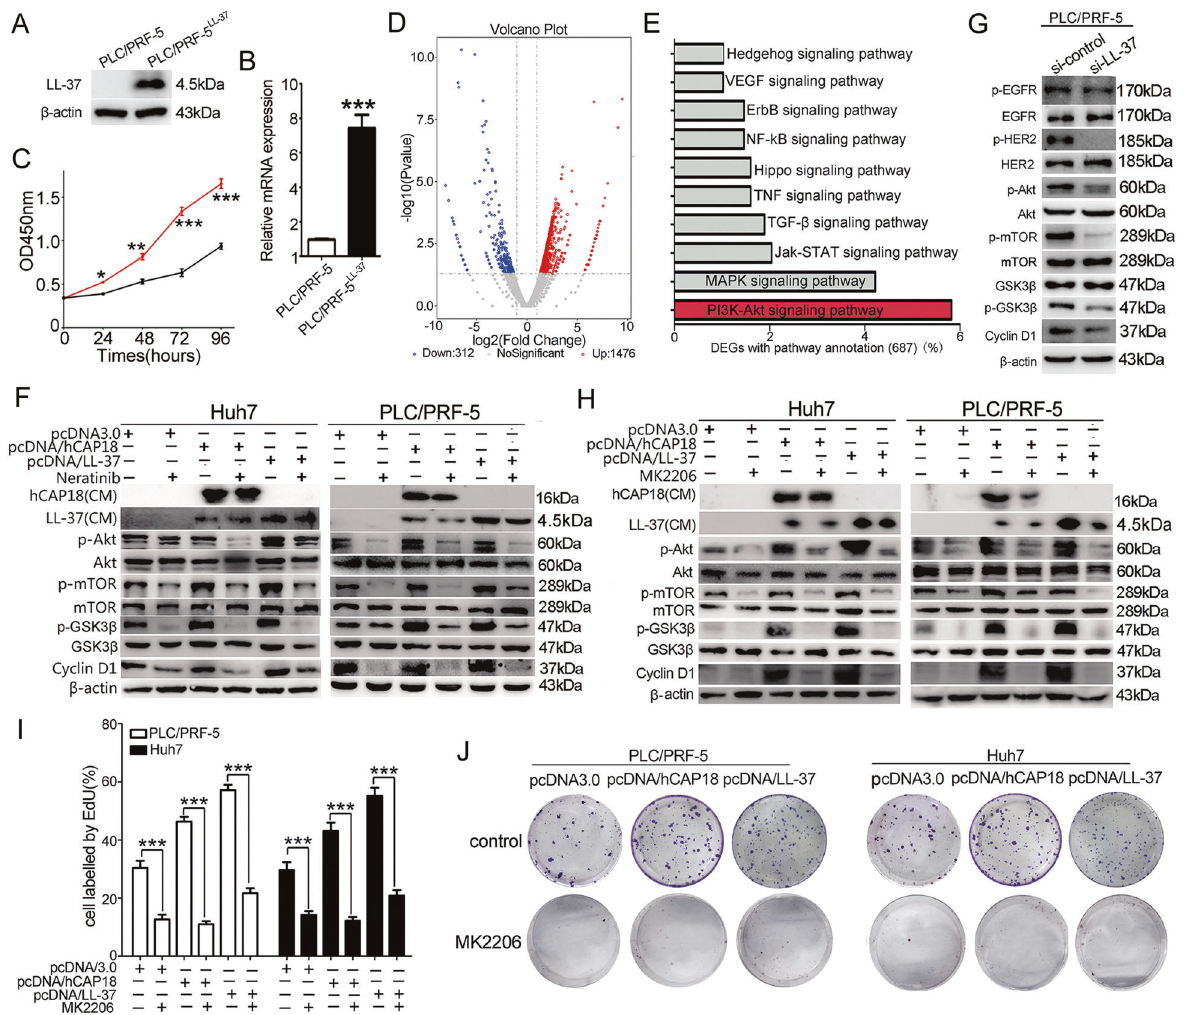
Fig. 5 hCAP18/LL-37 regulates PI3K/Akt signaling pathway in HCC cells. Stable LL-37-overexpressing cell line PLC/PRF-5 LL-37 was veri fi ed by western blotting ( A ), qRT-PCR ( B ), and cell growth curve analysis by CCK-8 assay ( C ). D Transcriptome sequencing identi fi ed genes involved in PLC/PRF-5 LL-37 . Volcano plot shows differential gene expression (red: upregulated; blue: downregulated) in PLC/PRF-5 LL-37 cells compared to PLC/PRF-5 cells. Log2 fold change is represented on x -axis, while y -axis represents – log10 p -value. E Top ten KEGG pathways enriched in genes differentially expressed in PLC/PRF-5 LL-37 cell. F PI3K/Akt pathway was measured in PLC/PRF-5 and Huh7 cells using western blotting. After transfection with pcDNA/hCAP18 or pcDNA/LL-37 for 24 h, 3 μ M neratinib was added. Protein levels were detected another 24 h. G After transfection with si-LL-37 for 48 h, protein levels were measured in PLC/PRF-5 cells. H After pcDNA/hCAP18 or pcDNA/LL-37 transfection for 24 h, AKT inhibitor (MK2206, 5 μ M) was added for another 24 h incubation and then protein levels were measured in PLC/PRF-5 and Huh7 cells. EdU proliferation assays ( I ) and colony formation assays ( J ) were conducted in Huh7 and PLC/PRF-5 cells with or without MK2206. Data are presented as the mean ± SEM for 4 – 6 different experiments. * p < 0.05, ** p < 0.01, *** p <